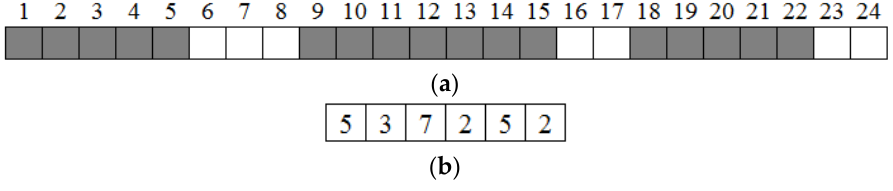
Figure 5. ( a ) Hourly on (grey) and off (white) states of an elastic load over 24 h; and ( b ) new encoding corresponding to that in 5a.